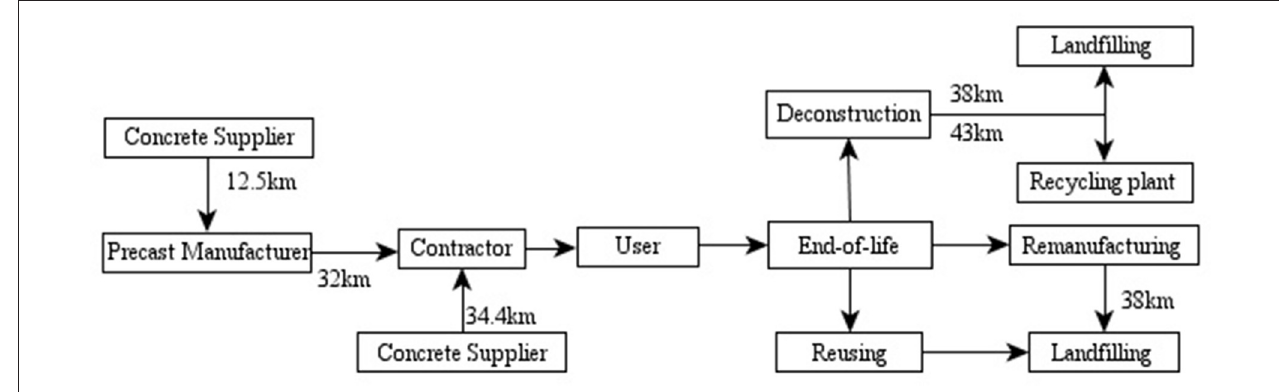
FIGURE 2 | Construction supply chain activities.